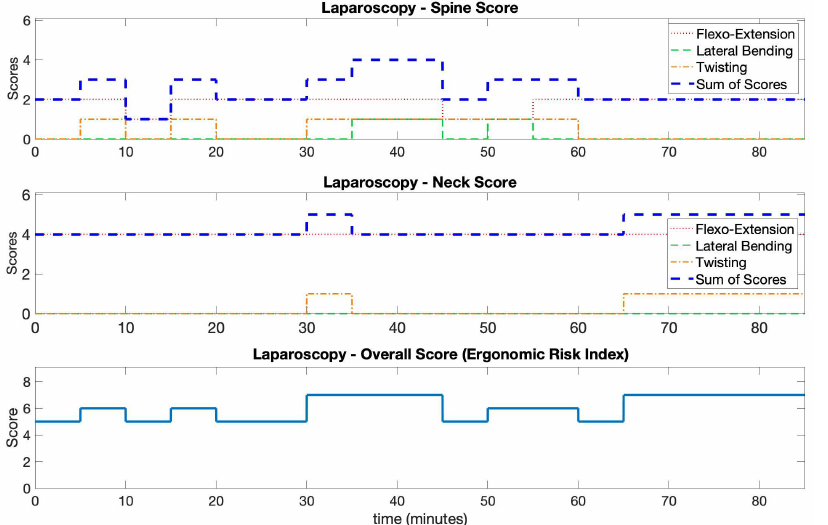
Figure 8. In this figure, the scoring results of the laparoscopy procedure are reported. The partial and total scores for the trunk and head, as well as the final score, obtained using the table in Figure 2, are shown.